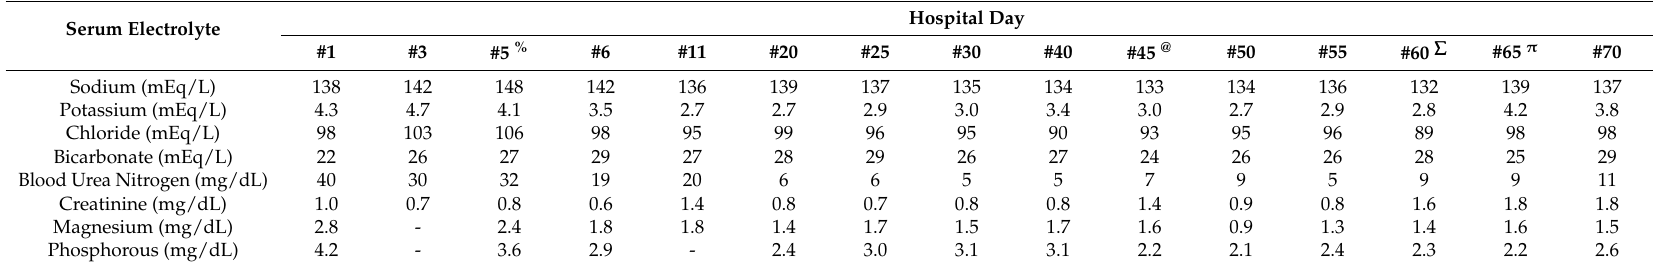
Table 1. Serum electrolytes during the hospital course.